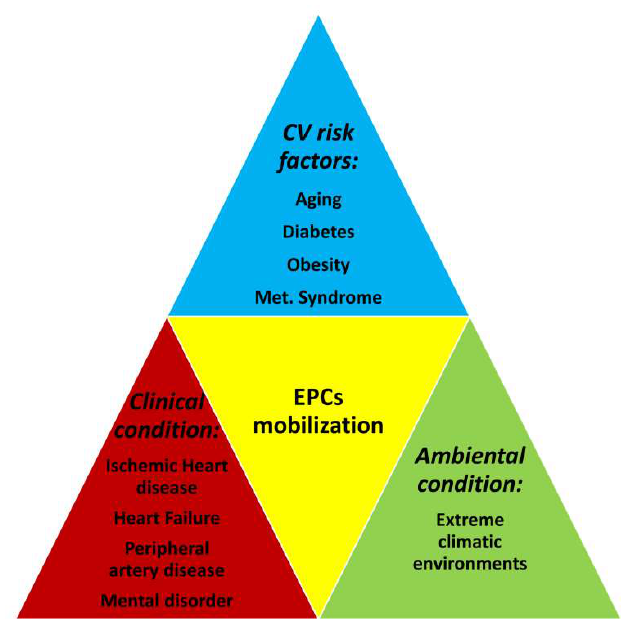
Figure 1. A snapshot describing the various clinical conditions associated with EPC mobilization.